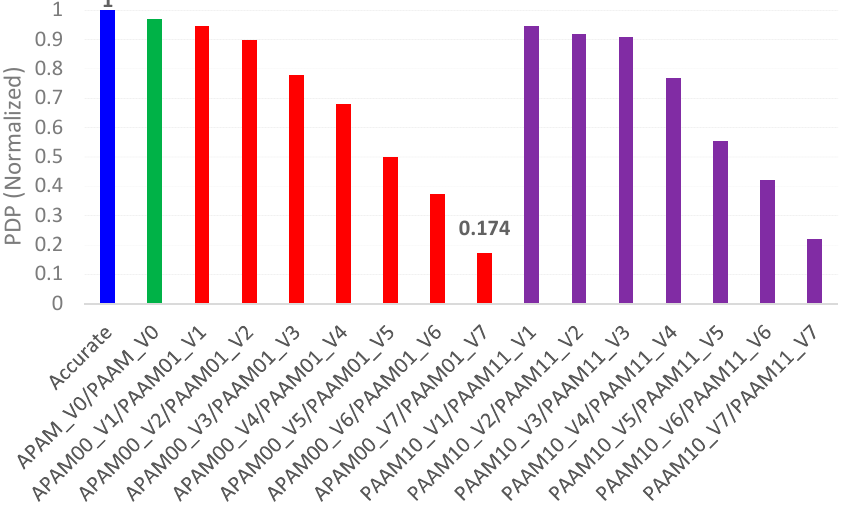
Figure 10. Normalized power-delay product (PDP) of accurate and approximate array multipliers.